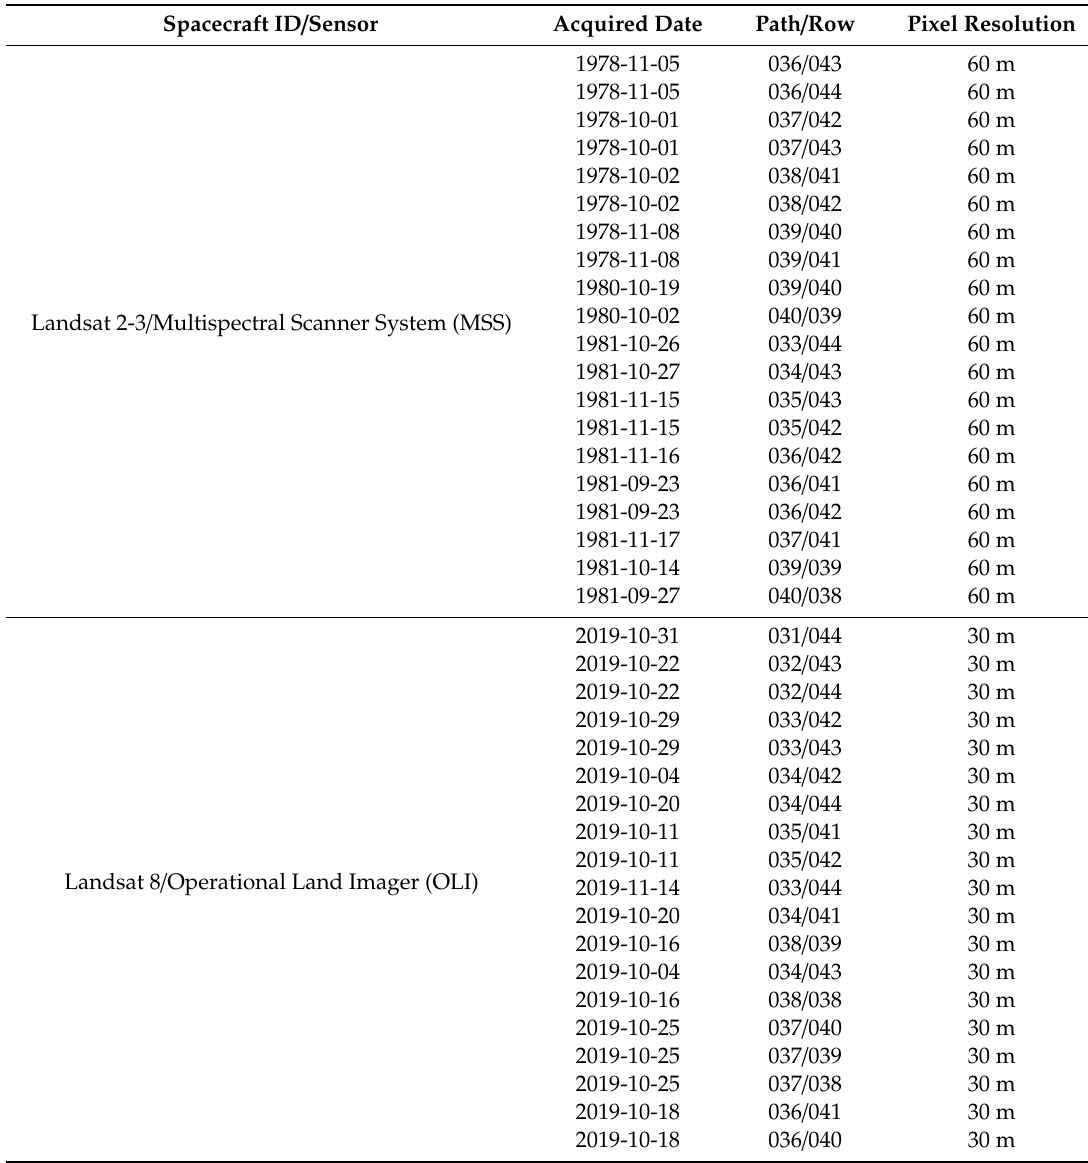
Table 1. Historical Landsat images used in the shoreline position